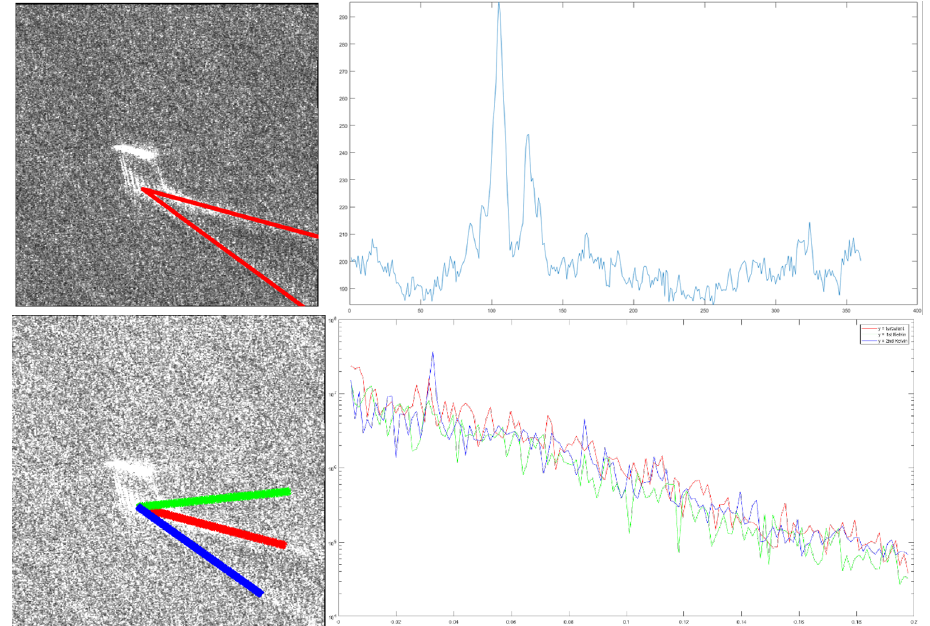
Figure 8. Detection of the wake linear envelopes and Kelvin wake spectral analysis for kinematics estimation. In the upper part, left side, the detected wake pattern has been highlighted in red; on the right, the Radon transform computed on the tip of the wake is plotted. It is worth observing the peaks in the Radon transform, corresponding to the detected wake arms. In the lower part, left side, the spectral analysis of the detected wake is depicted. The signal samples extracted along the wake arms (here differentiated through different colors) are then exploited to estimate the corresponding power spectra, displayed on the right side.